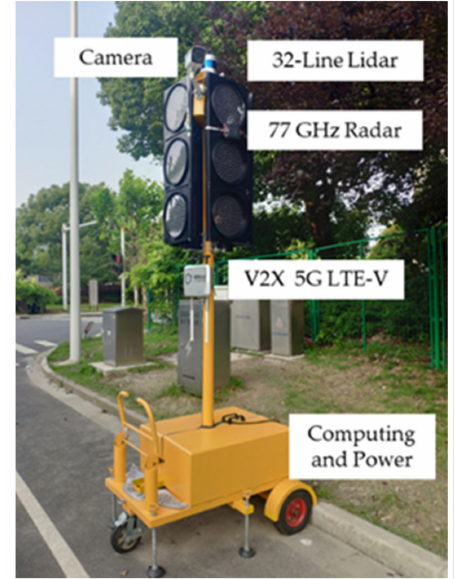
Figure 5. The movable intelligent roadside sensing and computing platform. The sensor unit consists of a radar, a camera, and a 32-line lidar; the vehicle-to-everything (V2X) unit uses the 5G LTE-V communication format; and the computing unit is an Nvidia